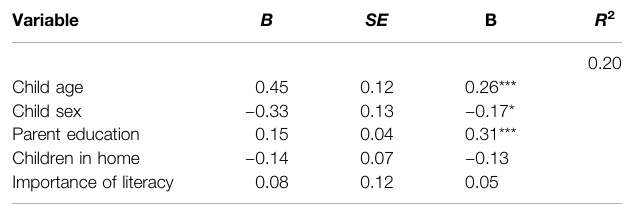
TABLE 3 | Multiple regression analysis predicting home literacy environment controlling for race/ethnicity.